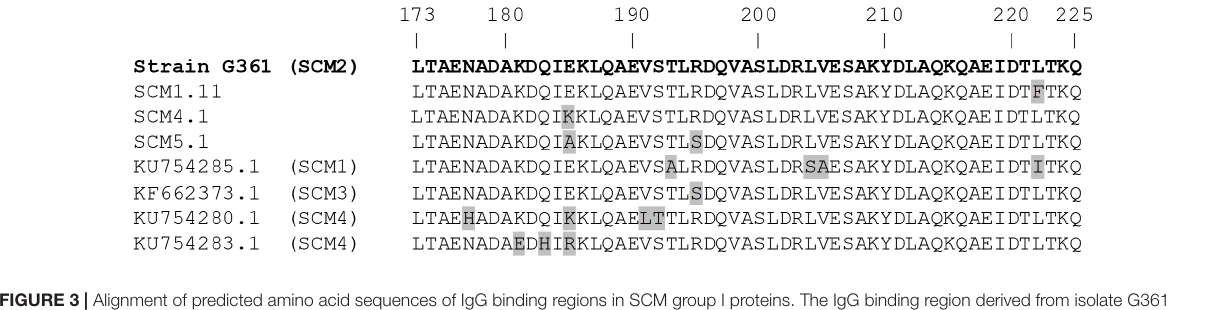
N -terminal portion of the protein ( Supplementary Figure 3